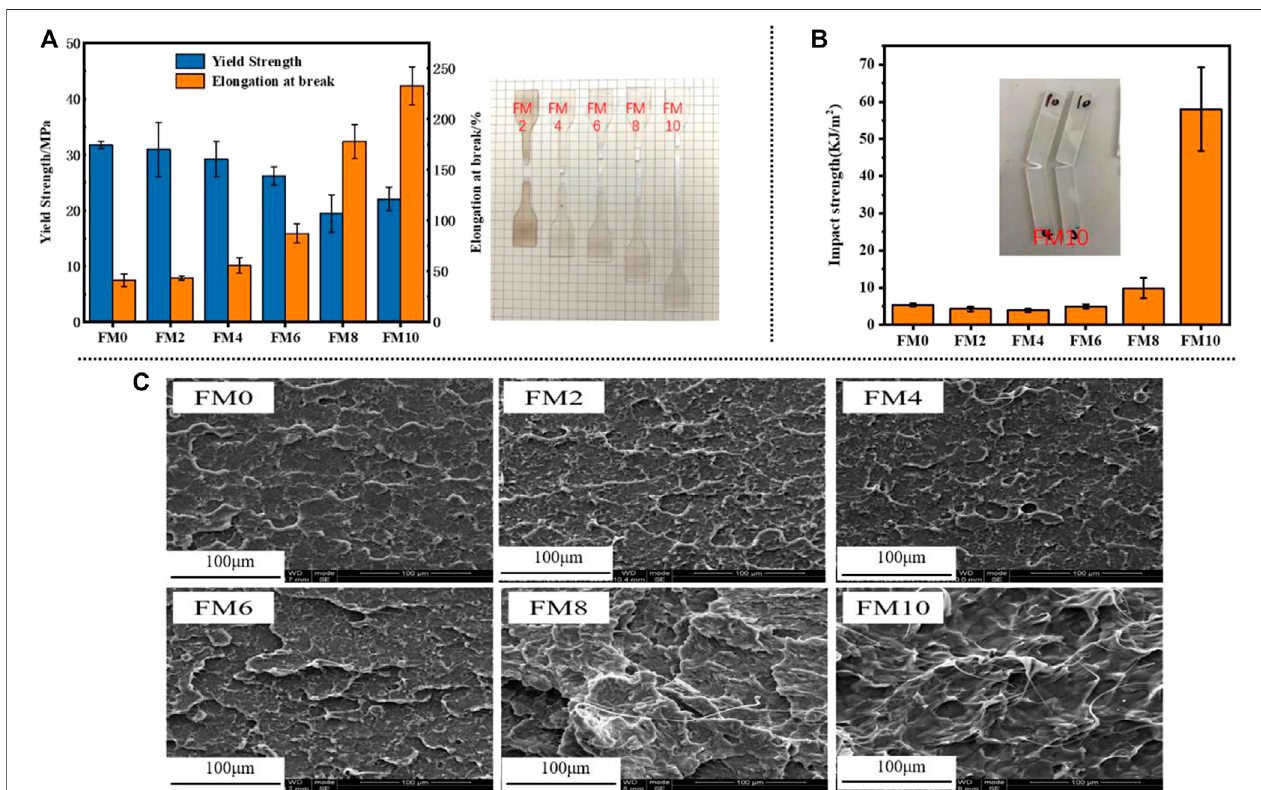
FIGURE9|(A) Yieldstrengthandelongationand (B) impactstrengthofPCTFEandPCTFE/FCOblends(thefracturedsamplesafterstretchingandimpactingwere also inserted); (C) SEM micrographs of the fractured surface of PCTFE and PCTFE/FCO blends after impacting.